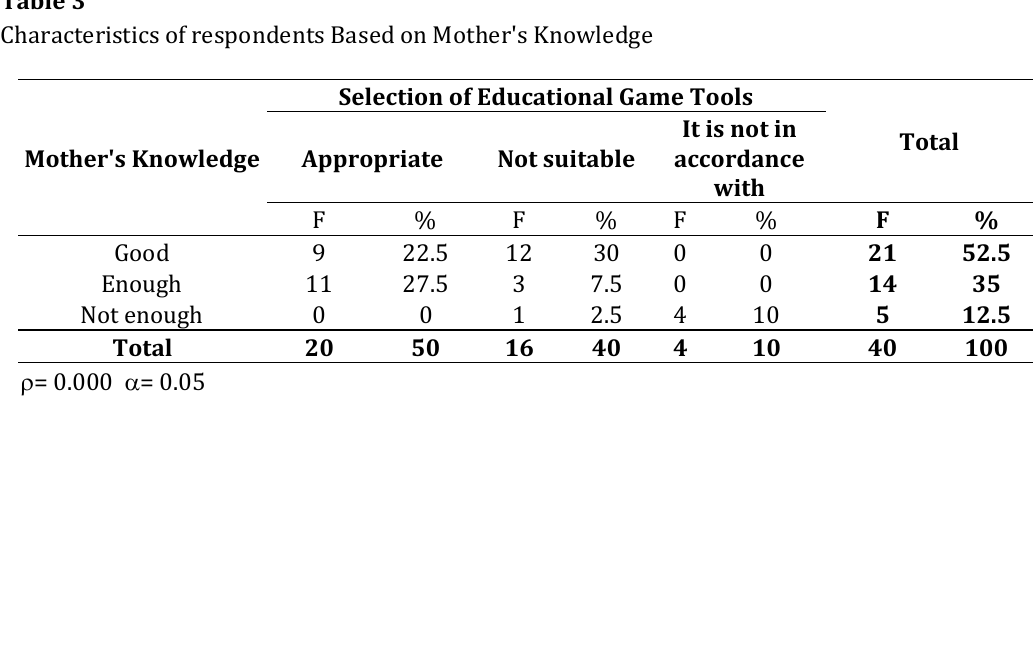
Characteristics of respondents Based on Mother's Knowledge